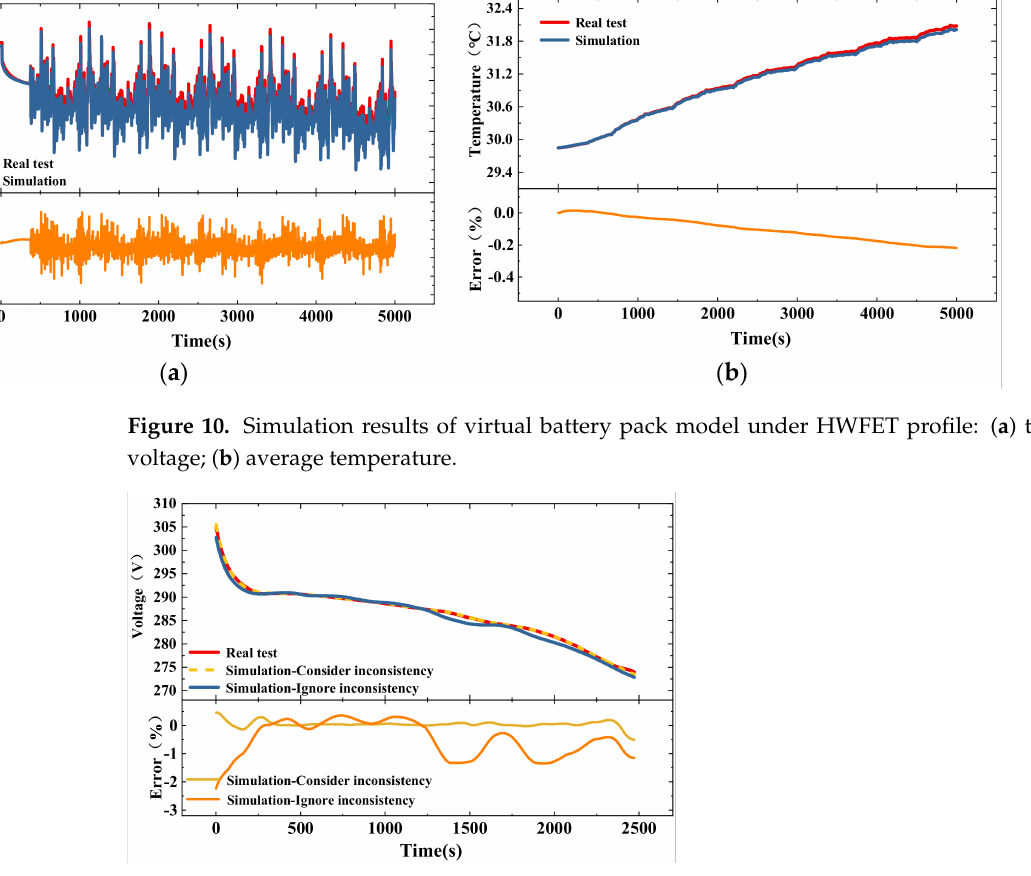
Figure 11. Constant current discharge comparison considering parameter inconsistency and ignoring parameter